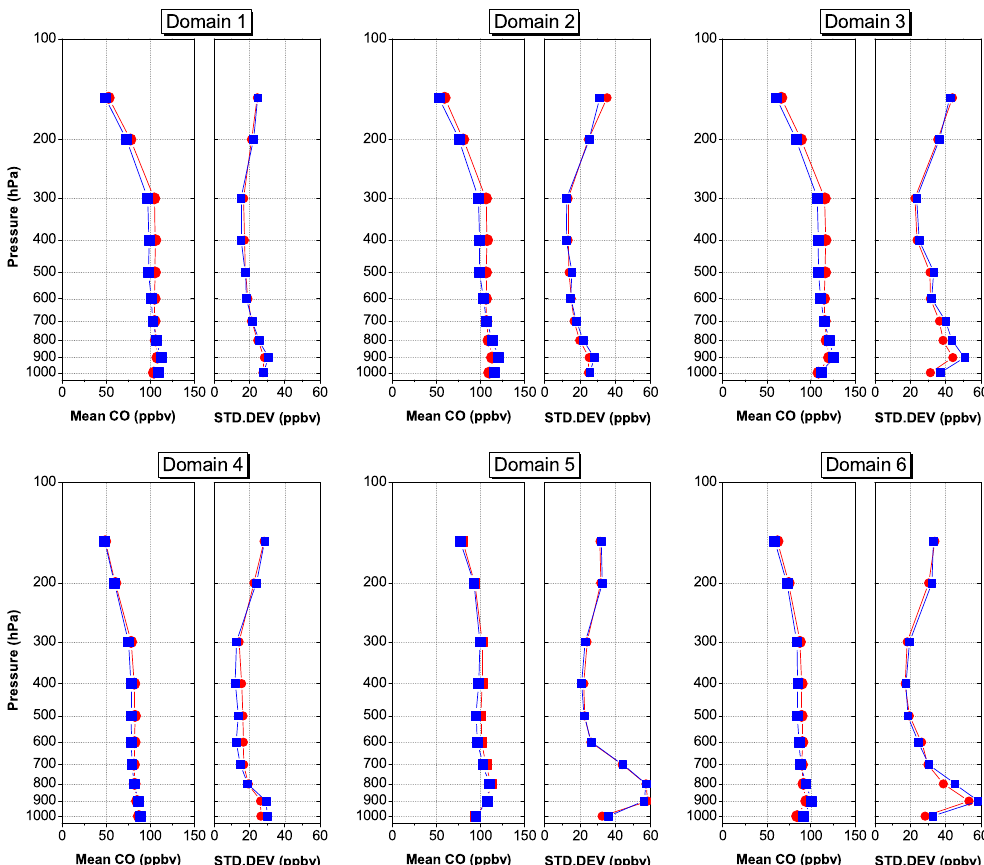
Figure 14. Mean CO vertical profiles and their associated standard deviations in parts per billion by volume (ppbv) deduced from MOPITT CO TOTCOL_ANALYSES (red) compared to MOPITT PROFILE_ANALYSES taking into account the averaging kernels as well as the error covariance matrices (blue). Both data sets are averaged over the month of August 2008 and over all the regional domains defined in Fig. 6.